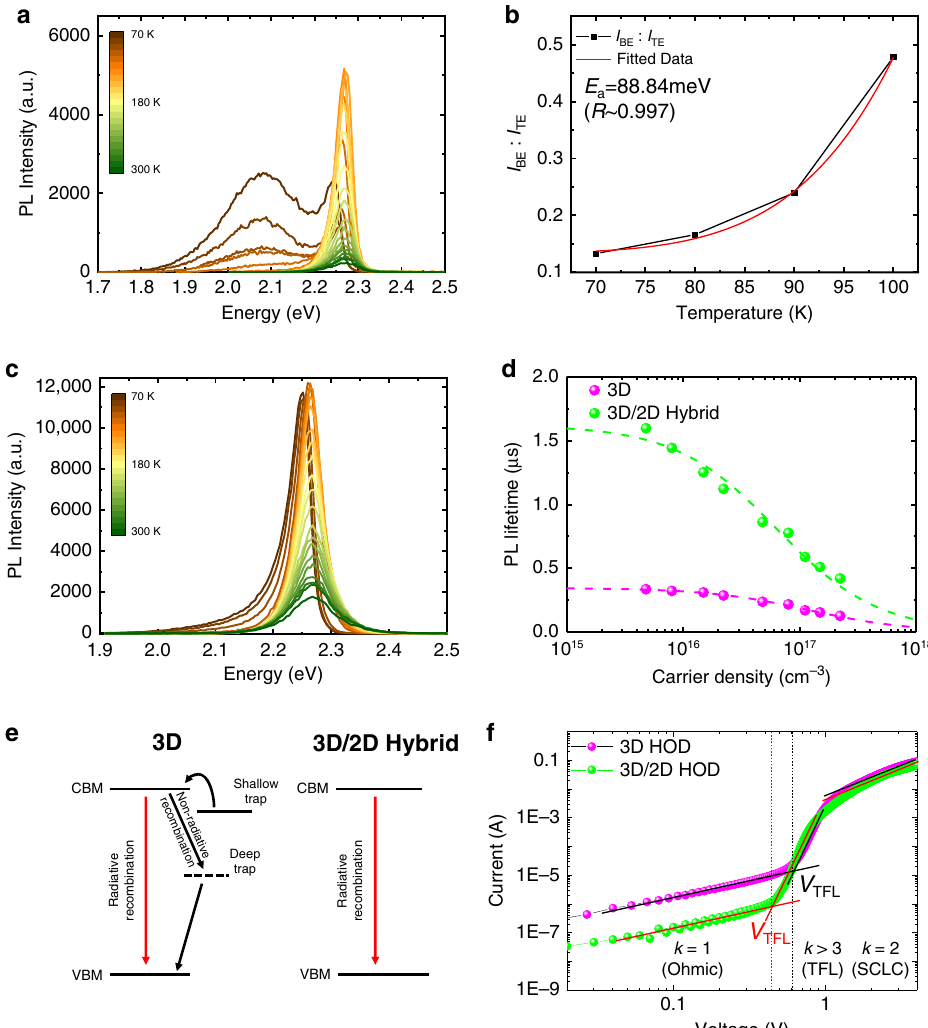
Fig. 5 Photo-physical analyses to investigate recombination kinetics and trap states of perovskites. a Temperature-dependent PL of 3D perovskite and b Ratio between integrated PL of band emission and trap-mediated emission of 3D perovskite as a function of temperature and its fi tted curve according to Boltzmann distribution function. c Temperature-dependent PL of 3D/2D hybrid perovskite. d Excited charge carrier density-dependent PL lifetimes of the perovskites. e Schematic of charge carrier recombination dynamics of the perovskites. f I – V curves of hole-only devices with 3D perovskite and 3D/2D hybrid